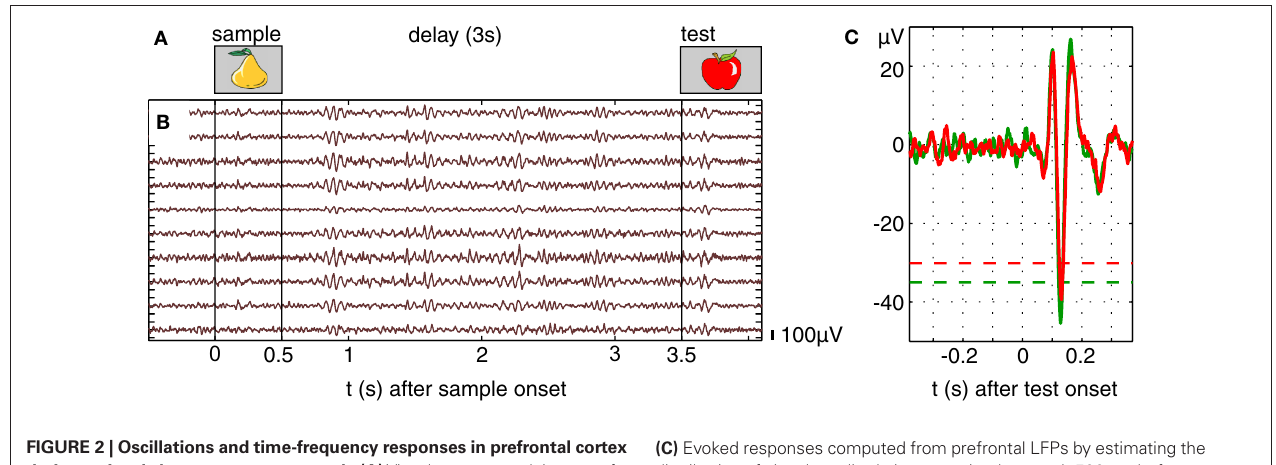
(C) Evoked responses computed from prefrontal LFPs by estimating the distribution of signal amplitude in a pre-stimulus epoch 500 ms before stimulus onset. Responses were considered signifi cant if fi ve or more successive bins exceeded a 1% threshold. Green and red traces represent evoked responses in trials with correct and false behavioral responses,